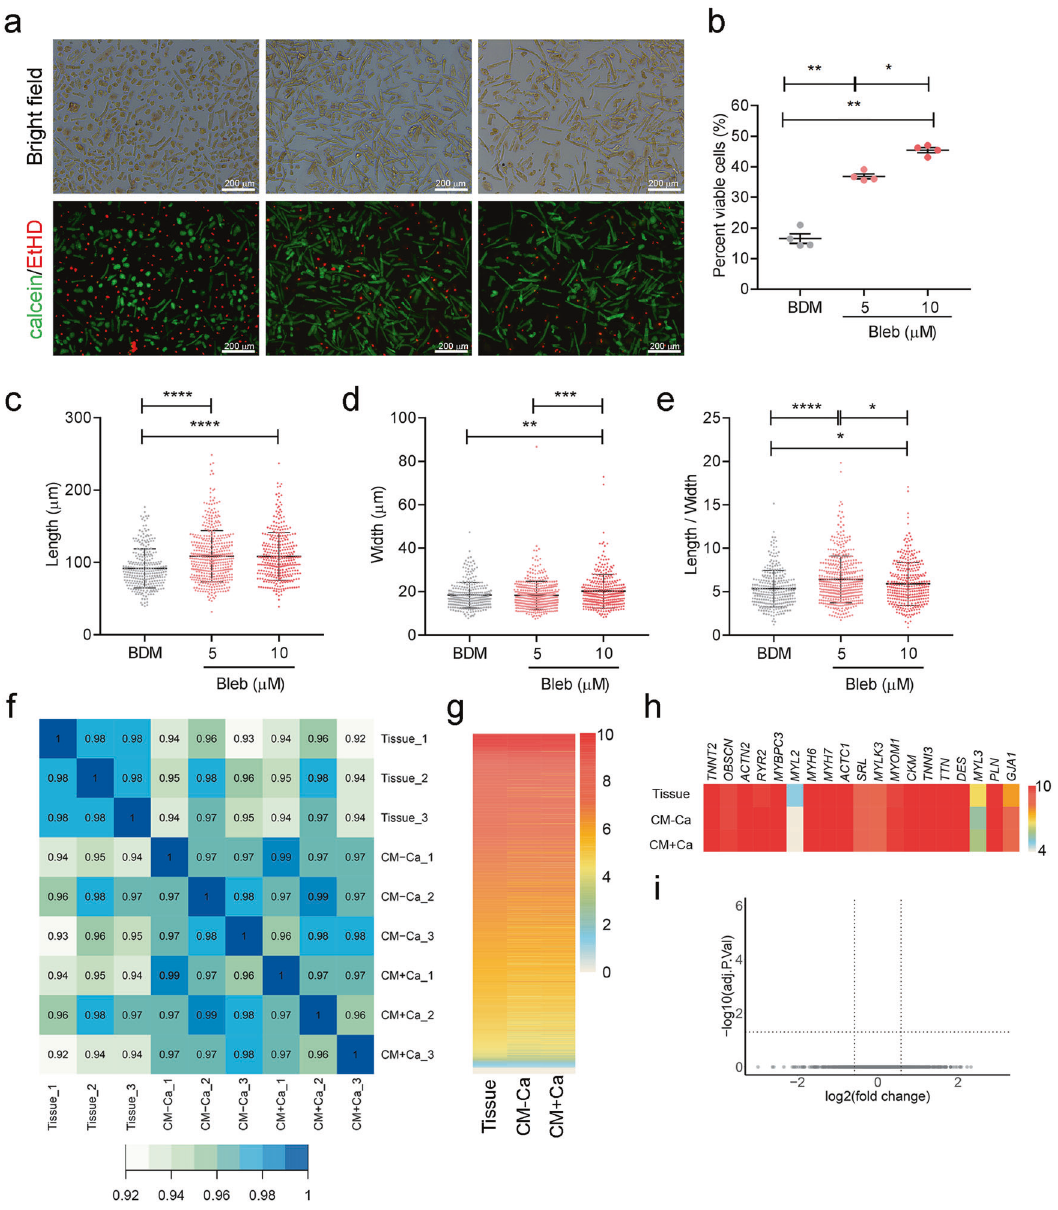
Fig. 1 Blebbistatin improves the isolation ef fi ciency of adult human primary cardiomyocytes (hPCMs) without changing gene expression. a Freshly isolated hPCMs were stained for cell viability using calcein AM (green, live) and ethidium homodimer-1 (red, dead). Scale bar = 200 μ m.Results are representative of four independent experiments. b Quanti fi cation of cell viability in a . Data were mean ± SEM, one-way repeated measures ANOVA. * P < 0.05, ** P < 0.005. c – e Quanti fi cation of ce ll lengths ( c ), cell widths ( d ), and length-to-width ratios ( e ) in a . Data were mean ± SD, one-way ANOVA. * P < 0.05, ** P < 0.005, *** P < 0.0005, **** P < 0.0001. f Spearman ’ s correlation between paired tissue and cell samples ( n = 3 biological repeats, denoted by the number at the end of sample name). Tissue, myocardial tissue specimen; CM-Ca, isolated hPCMs prior to calcium reintroduction; CM + Ca, isolated hPCMs after calcium reintroduction. g Ranking of mean expression of genes. h Expression of CM marker genes. i Volcano plot of differentially expressed genes (DEGs) between hPCMs before and after calcium normalized to cell capacitance was − 39.27 ± 14.50 pA/pF ( n = 10) currents ( I Ca,L ) currents were elicited at potentials between − 60 (Fig. 2a). We also characterized the voltage-dependent steady- to + 90 mV, with 30 mV steps at a holding potential of − 80 mV. state activation and inactivation curves of sodium currents. The The I – V relationship showed that the peak density of calcium voltage at half activation ( V 1/2 ) was − 35.07 ± 0.87 mV ( n = 10), currents occurred at 30 mV, and the mean maximal peak I Ca,L normalized to cell capacitance was − 3.66 ± 0.98 pA/pF ( n = 4) with a mean slope factor ( k ) of 3.43 ± 0.76, whereas the V 1/2 for inactivation − 72.13 ± 0.54 mV ( n = 10), and the slope factor was (Fig. 2e). The V 1/2 for inactivation of I Ca,L was − 13.04 ± 0.93 mV, 4.30 ± 0.47 (Fig. 2b, c). Time-dependent recovery of sodium with a mean slope factor of 5.96 ± 0.76 ( n = 4) (Supplementary Fig. currents from inactivation was assessed using a paired-pulse S3a). The mean recovery time constant of I Ca,L was 135.2 ± 6.6 ms protocol. The mean recovery time constant of sodium currents ( n = 4) (Supplementary Fig. S3b). We further characterized the was 3.83 ± 0.35 ms ( n = 10) (Fig. 2d). Likewise, L-type Ca 2 + current – voltage (I – V) relationships of two major potassium